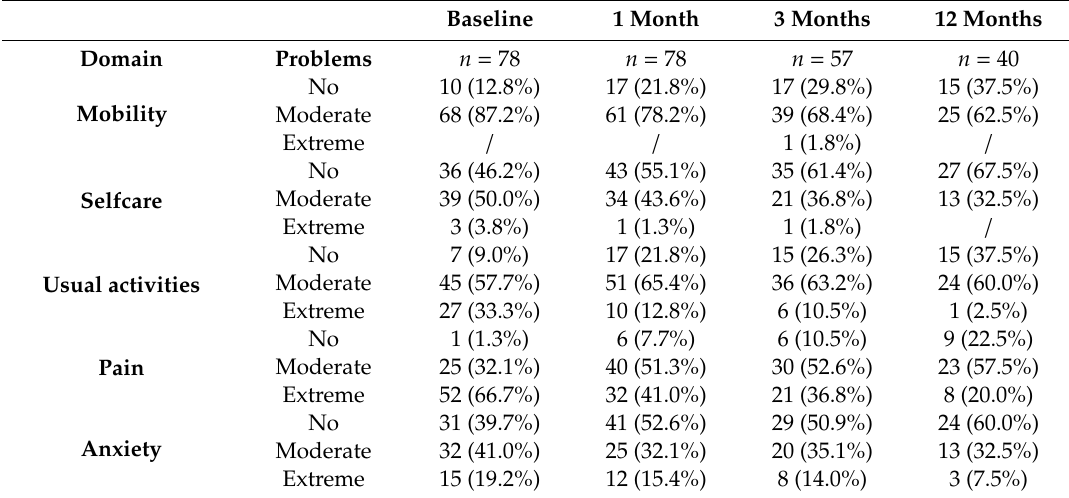
Table 2. Summary of reported problems in each domain of the EQ-5D-3L for all patients. Baseline 1